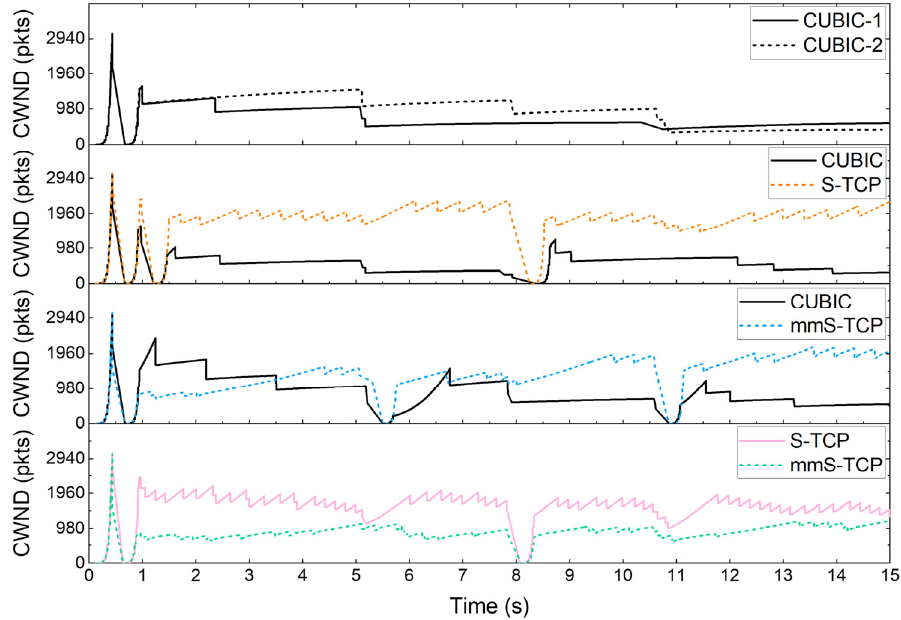
Figure 11. Cwnd variation in competition between two flows.